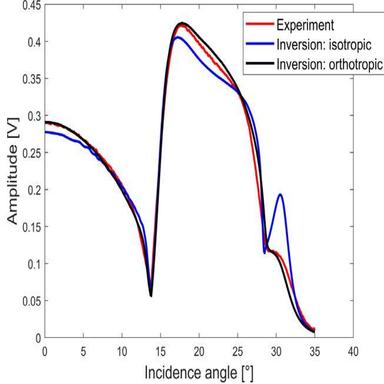
Cross-section (ϕ = 0) of the TOF P-UPS experiment (red) for an aluminum plate of thickness d = ± 1.500 0.002 mm, together with the results of stage I of the inversion procedure for respectively the isotropic (black) and the orthotropic symmetry assumption (blue).